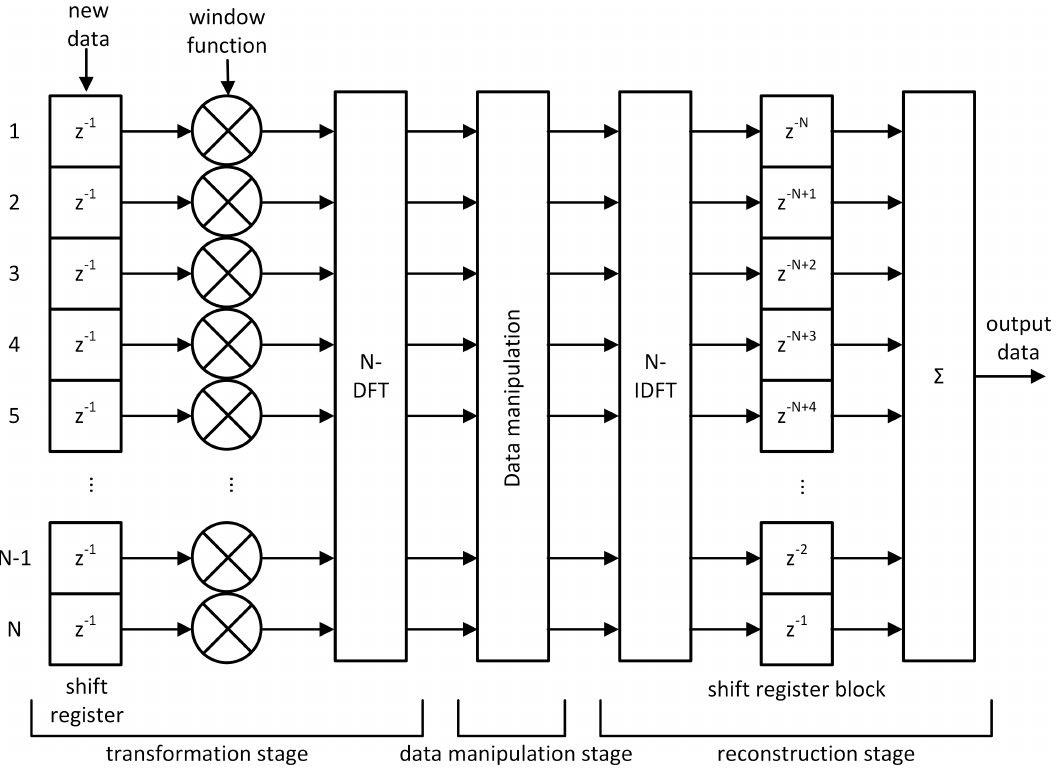
Figure 5. HDDM block diagram. ©IEEE. Reprinted, with permission, from